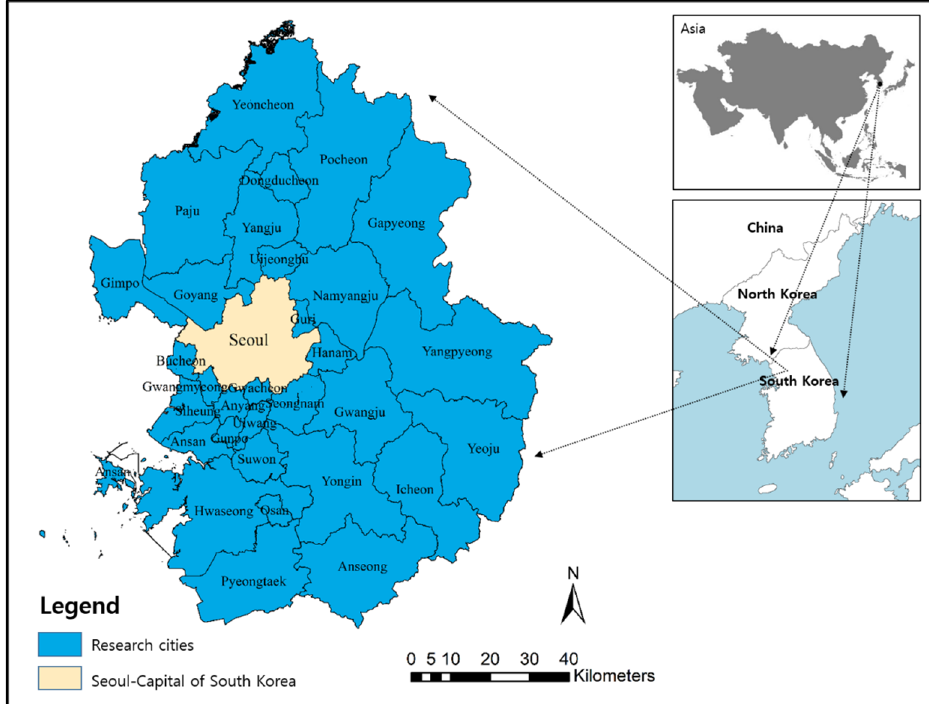
Figure 1. Location of research cities.